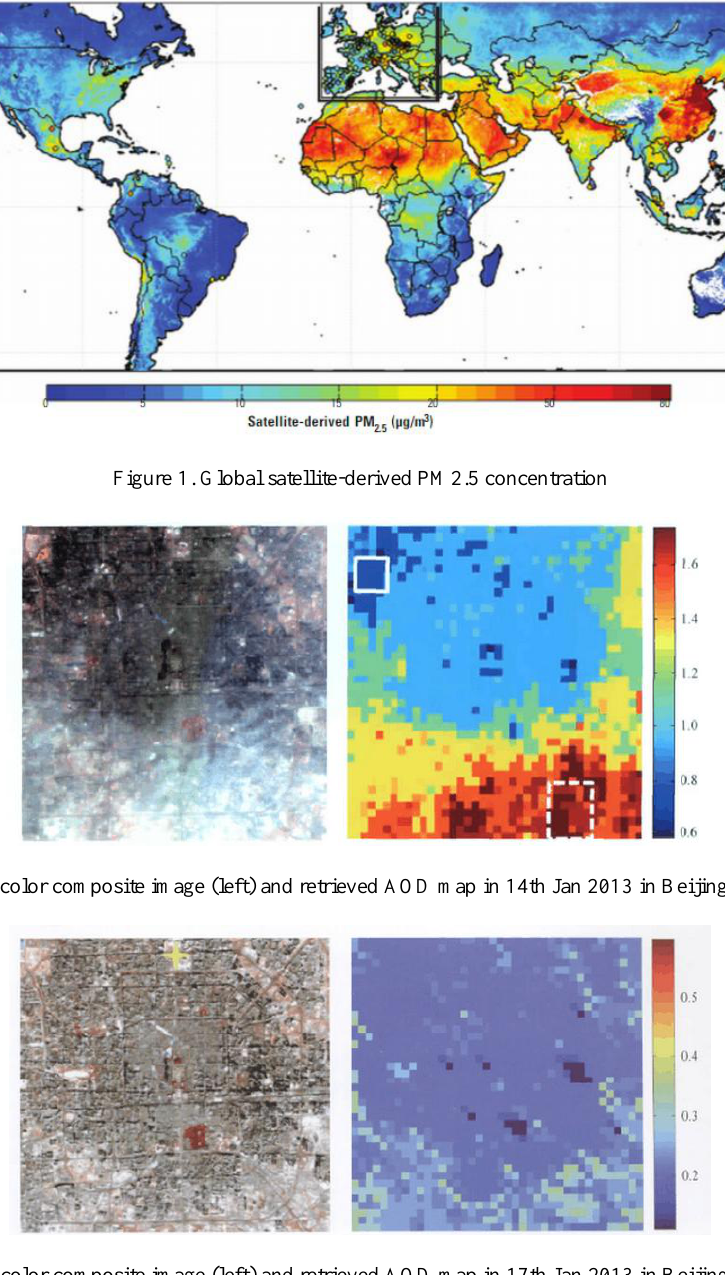
Figure 2. Image and AOD map of China HJ-1